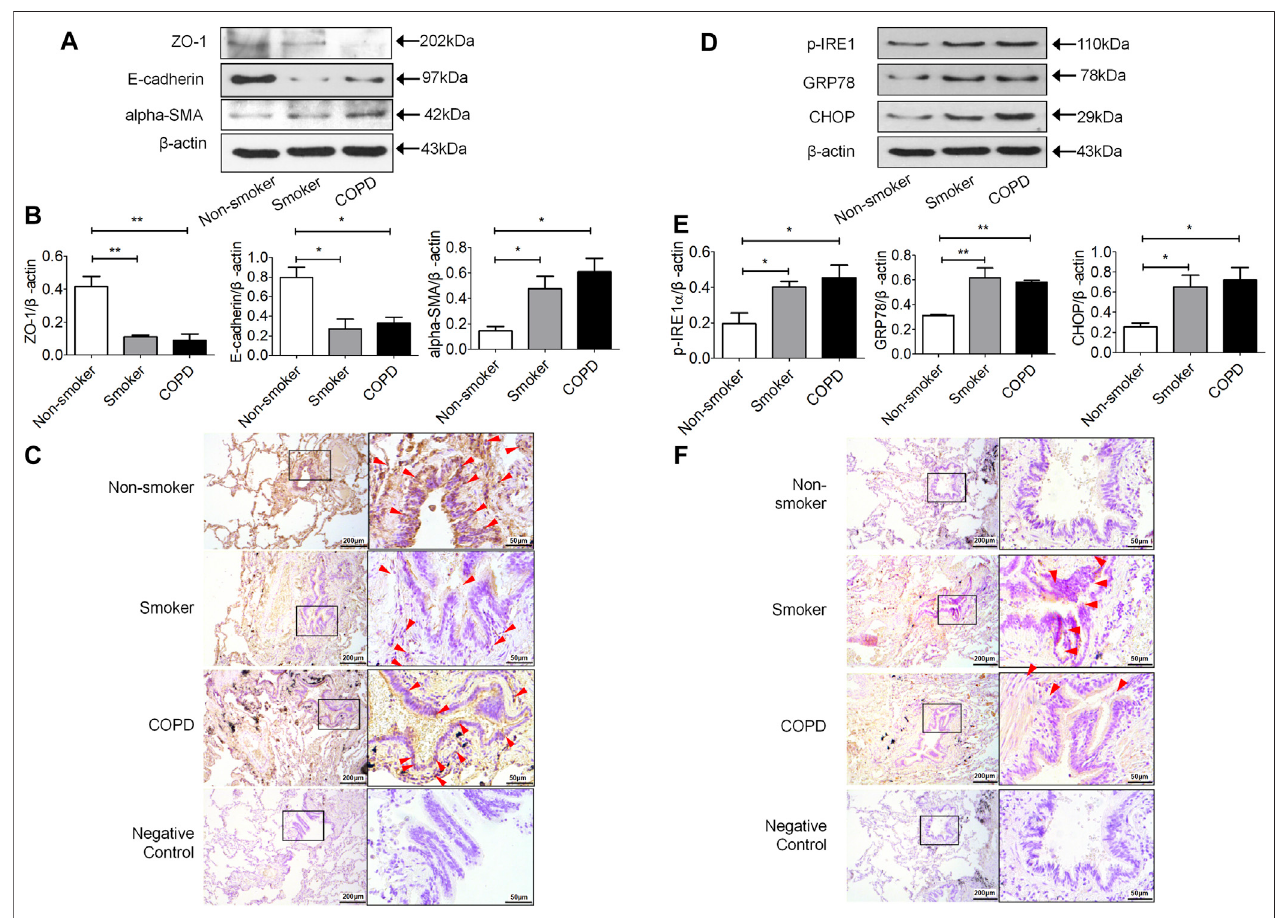
FIGURE 1 | The expression of mesenchymal differentiation markers increased in the lung tissueof smokersand COPD patients. (A,B) Western blotting analysis of ZO-1, E-cadherin and alpha-SMAproteinexpression in thelung tissue ofnonsmokers, smokers, and COPD patients, and relative intensitynormalizedtothe expression of β -actin( n =3,respectively,ineachgroup).Thealuesareexpressedasmean±SEM.* p < 0.05,** p < 0.01vs.non-smokergroup. (C) ImmunolocalizationofE-cadherin inhumanlungtissues.E-cadherin(redarrow)waslocalizedtothecytoplasmoflungepithelialcellswithlighterstaininginlungtissueofsmokersandCOPDpatients as compared to non-smokers. Representative images ( n = 4, respectively, in each group). Original magni fi cation ×100 and ×400. The expression of ER stress markers increased in the lung tissue of smokers and COPD patients. (D,E) Western blotting analysis of p-IRE1, GRP78 and CHOP protein expression in lung tissue of nonsmokers, smokers, and COPD patients, and relative intensity normalized to the expression of β -actin ( n = 3, respectively, in each group). Values are expressed as mean ± SEM. * p < 0.05, ** p < 0.01 vs. non-smoker group. (F) Immunolocalization of p-IRE1 in human lung tissues. P-IRE1 (red arrow) was expressed in lung epithelial cells and smooth muscle cells, and p-IRE1 staining was signi fi cantly more intense and frequent in the lung tissue of smokers and COPD patients as compared to non- smokers. Representative images ( n = 4, respectively, in each group). Original magni fi cation ×100 and ×400.